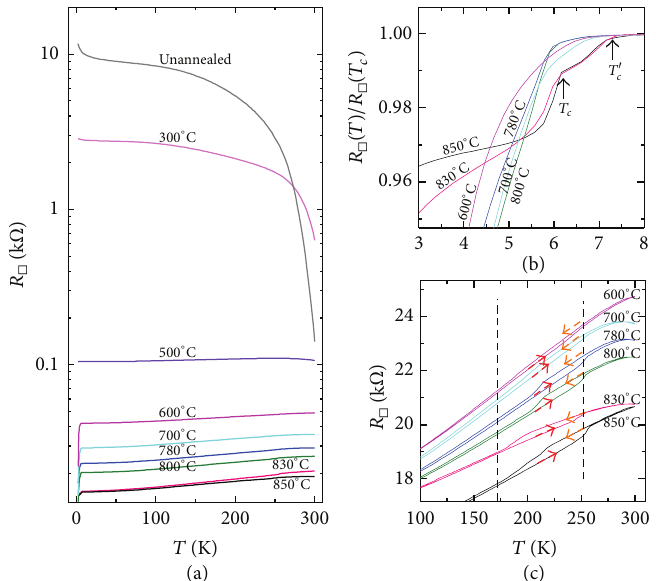
Figure 2: (a) 𝑇 dependence of the sheet resistance 𝑅 ◻ for samples with the different annealing temperatures. (b) The enlarged plot of (a) near the superconducting transition temperature 𝑇 𝑐 . (c) The thermal hysteresis curves for the samples annealed at temperature window (600 ∘ C– 850 ∘ C). The arrows show the direction of the thermal